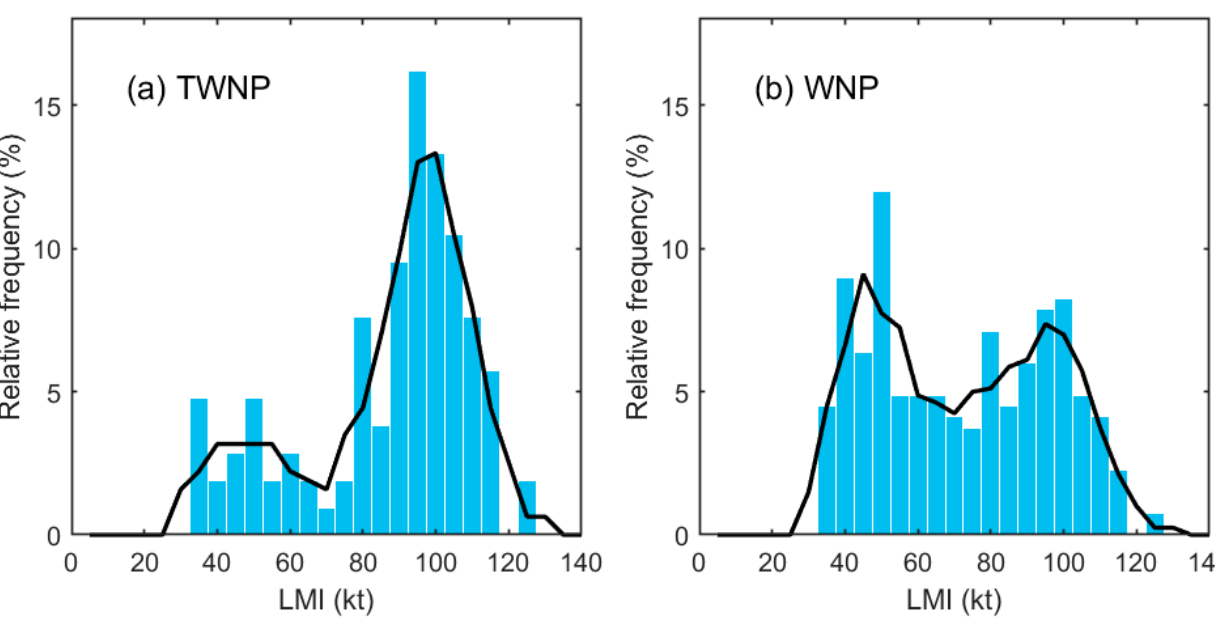
Figure 2. Distribution of lifetime maximum intensity. The relative frequencies presented were calculated on the basis of the 2004–2016 tropical cyclones in ( a ) the tropical western North Pacific (i.e., Cluster 2 in CSTIPS-DAT) and ( b ) the western North Pacific. The blue bars show the raw data binned into 5 kt bins. The black lines present the smoothed relative frequencies with a window width of 15 kt.